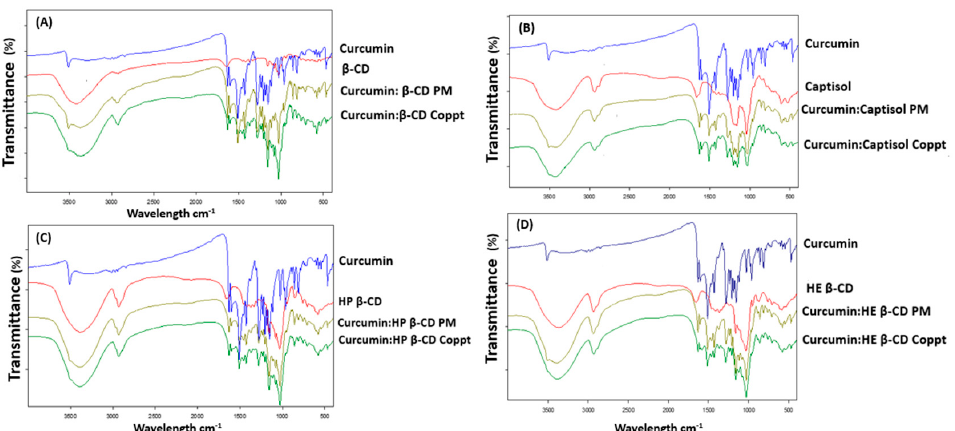
Figure 4. A–D. FTIR spectra of curcumin, curcumin: cyclodextrin complexes β -cyclodextrin ( A ), Captisol ( B ), hydroxypropyl β -cyclodextrin ( C ), and hydroxyethyl β -cyclodextrin ( D ) prepared by